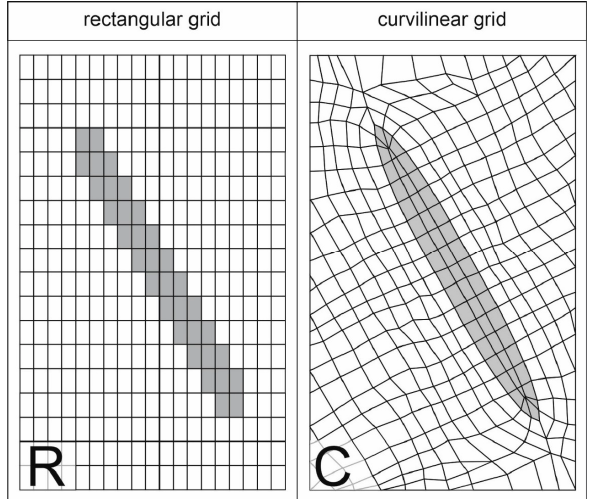
Figure 1. Images (not to scale) showing the basic differences between the different grid geometries applied. Left: The rectangular approach ( R ) uses a regular, rectangular grid in which fault zone properties are assigned to those cells intersected by the fault plane. Due to the underlying grid geometry, a staircase-shaped fault representation results. Right: The curvilinear approach ( C ) uses an irregular grid geometry which is adapted to the fault geometry. This allows the representation of the true shape of the fault zone in the FE model.